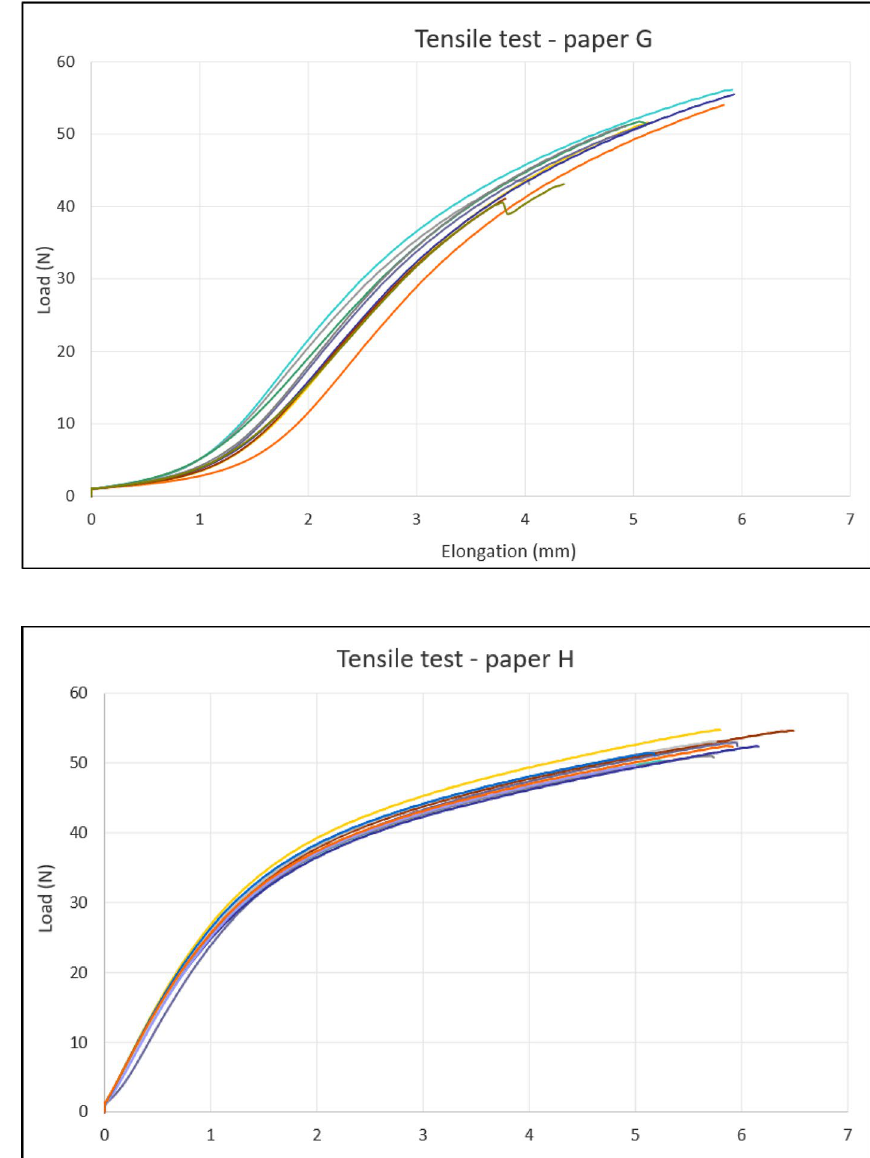
Fig. 38 Force elongation curves of individual specimen of paper G